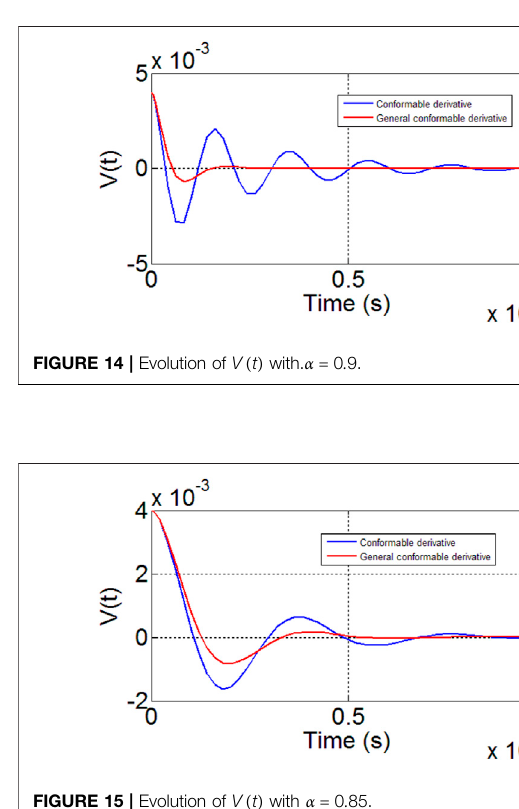
FIGURE 15 | Evolution of V ( t ) with α (cid:2) 0 . 85.